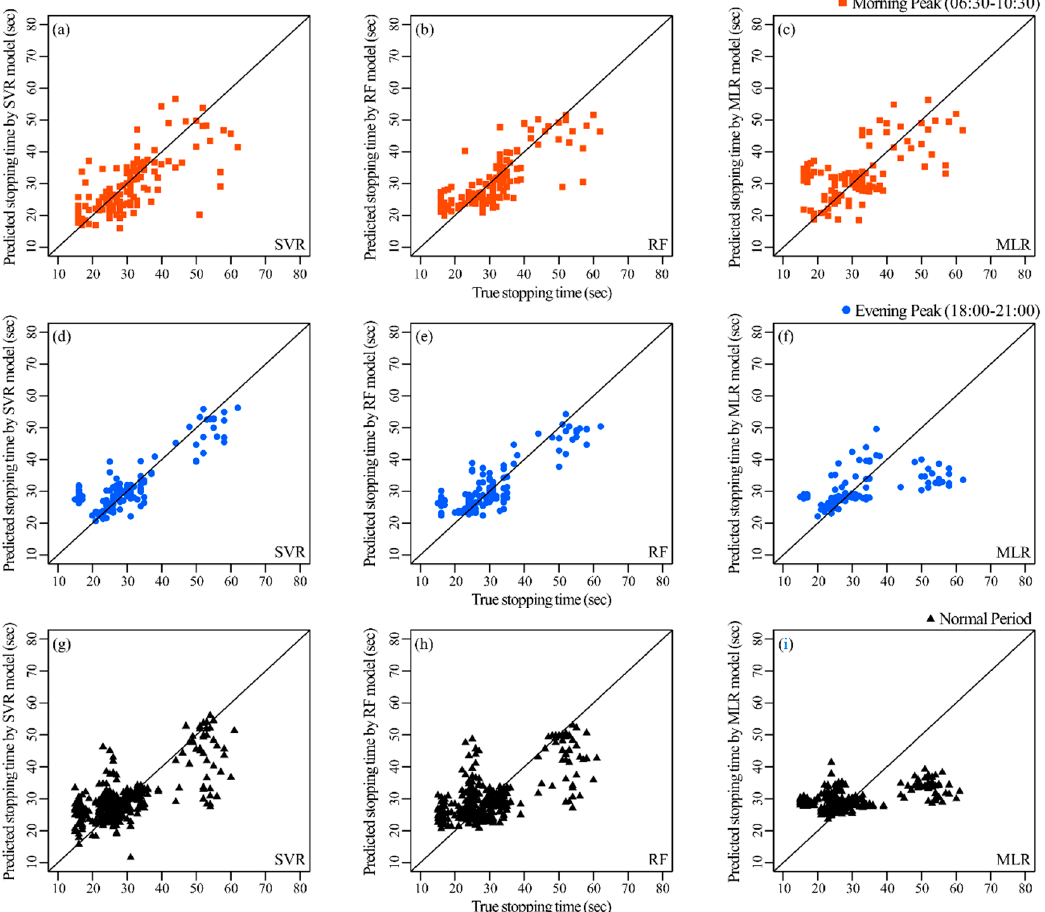
Figure 9. Dwell time estimation performance comparison by the time of day. ( a ~ c ) in the morning peak, ( d ~ f ) in the evening peak and ( g ~ i ) in the normal period.